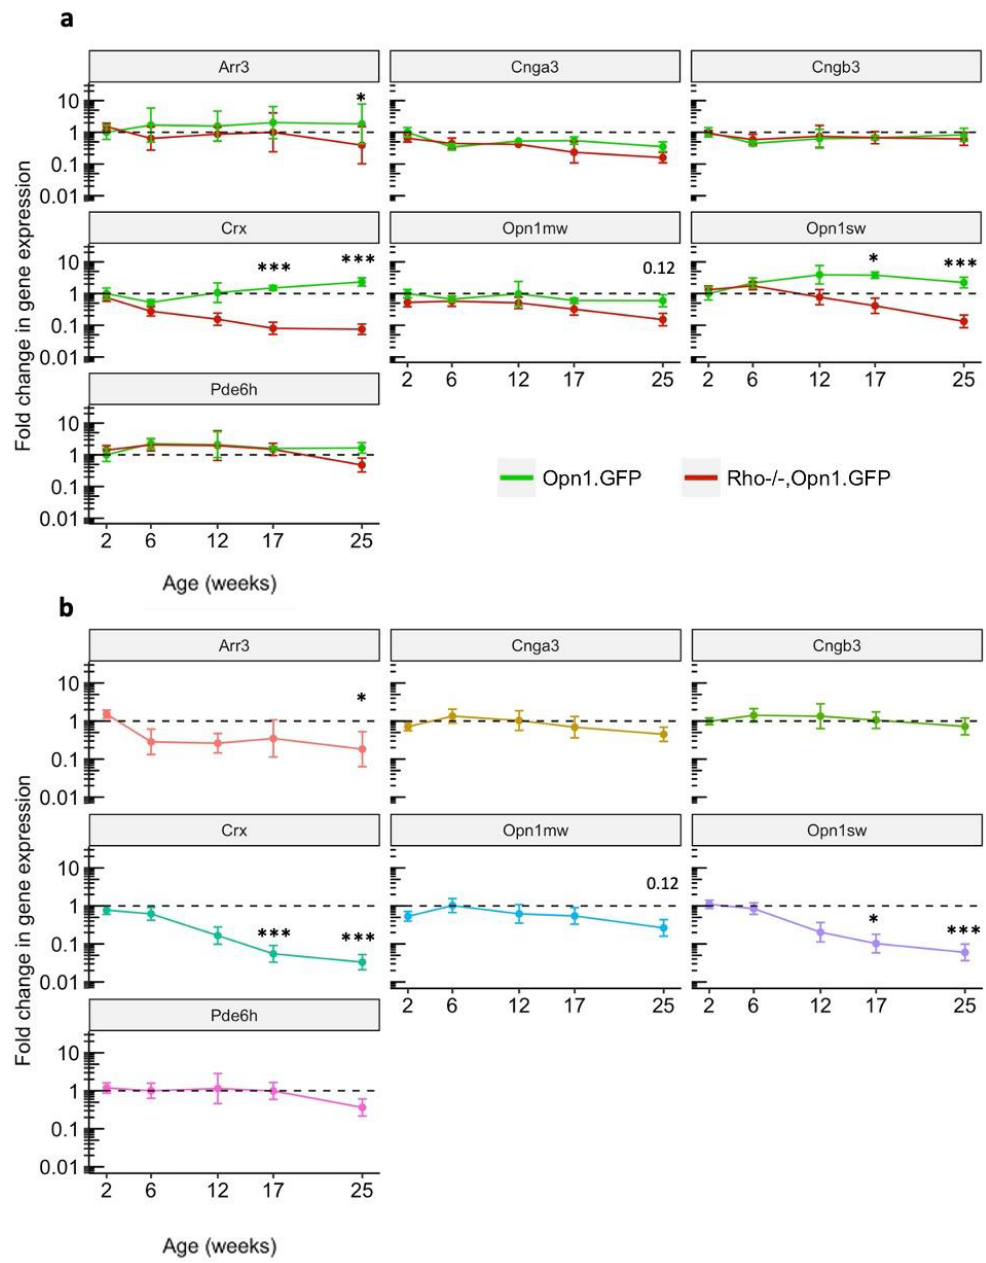
Figure 1. Gene expression analysis of cone phototransduction genes. ( a ) Gene expression data over time (post-natal week, PNW, 2, 6, 12, 17 and 25) showing 2 − ∆∆ C q values for Rho − / − OPN1-GFP mice and OPN1-GFP mice. ∆∆ Ct values calculated by double normalizing the test gene to the mean of ActB and GFP reference gene levels, then comparing each time point against OPN1-GFP mouse expression levels at PNW2 baseline. The dotted line represents the gene expression baseline of OPN1-GFP mice at PNW2 for each gene. Crx and Opn1sw genes show significantly di ff erent reduced expression patterns at PNW17 and PNW25, a trend that is already emerging at PNW12. The other genes are not significantly di ff erent between genotypes, but many do significantly change from PNW2 baseline. ( b ) The same gene expression data, displaying ∆∆ Ct values calculated by double normalizing the test gene to the mean of ActB and GFP reference gene levels, then comparing each time point against OPN1-GFP mouse expression levels at the same time point ( OPN1-GFP1 values represented by the dotted line). Full statistical model results available in Supplementary Table S1; All values are mean ± SEM. Tissue samples collected at PNW2 (OPN1-GFP n = 8, Rho − / − OPN1-GFP n = 8), PNW6 ( n = 3, n = 5), PNW12, ( n = 3, n = 3), PNW17 ( n = 3, n = 4), and PNW25 ( n = 3, n = 3). * denotes p < 0.05, *** denotes p <